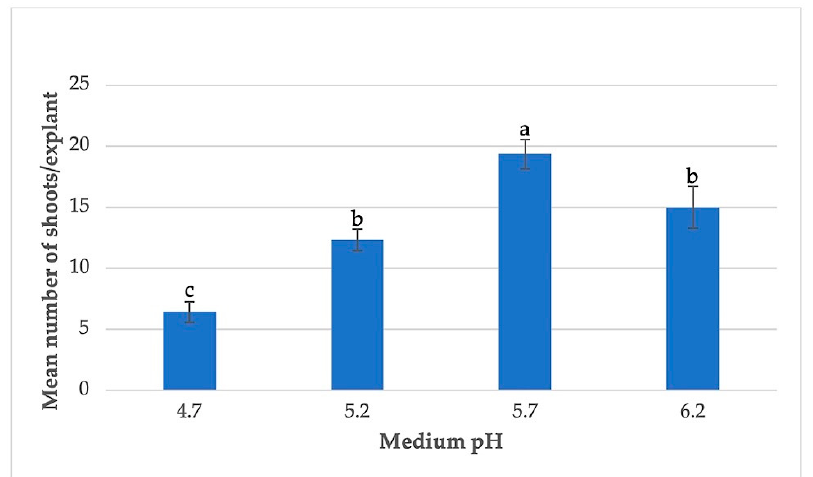
Figure 3. Effect of different pH of the MS medium with optimized concentration of 6-benzyladenine (BA) on shoot regeneration from axillary node explants of Plectranthus amboinicus . Data are expressed as mean ± SE recorded after 8 weeks of culture on shoot induction medium. Bars denoted with different letters indicate significant differences among treatments according to Tukey’s honestly significant difference test (Tukey’s HSD) at a p -value of less than 0.05.